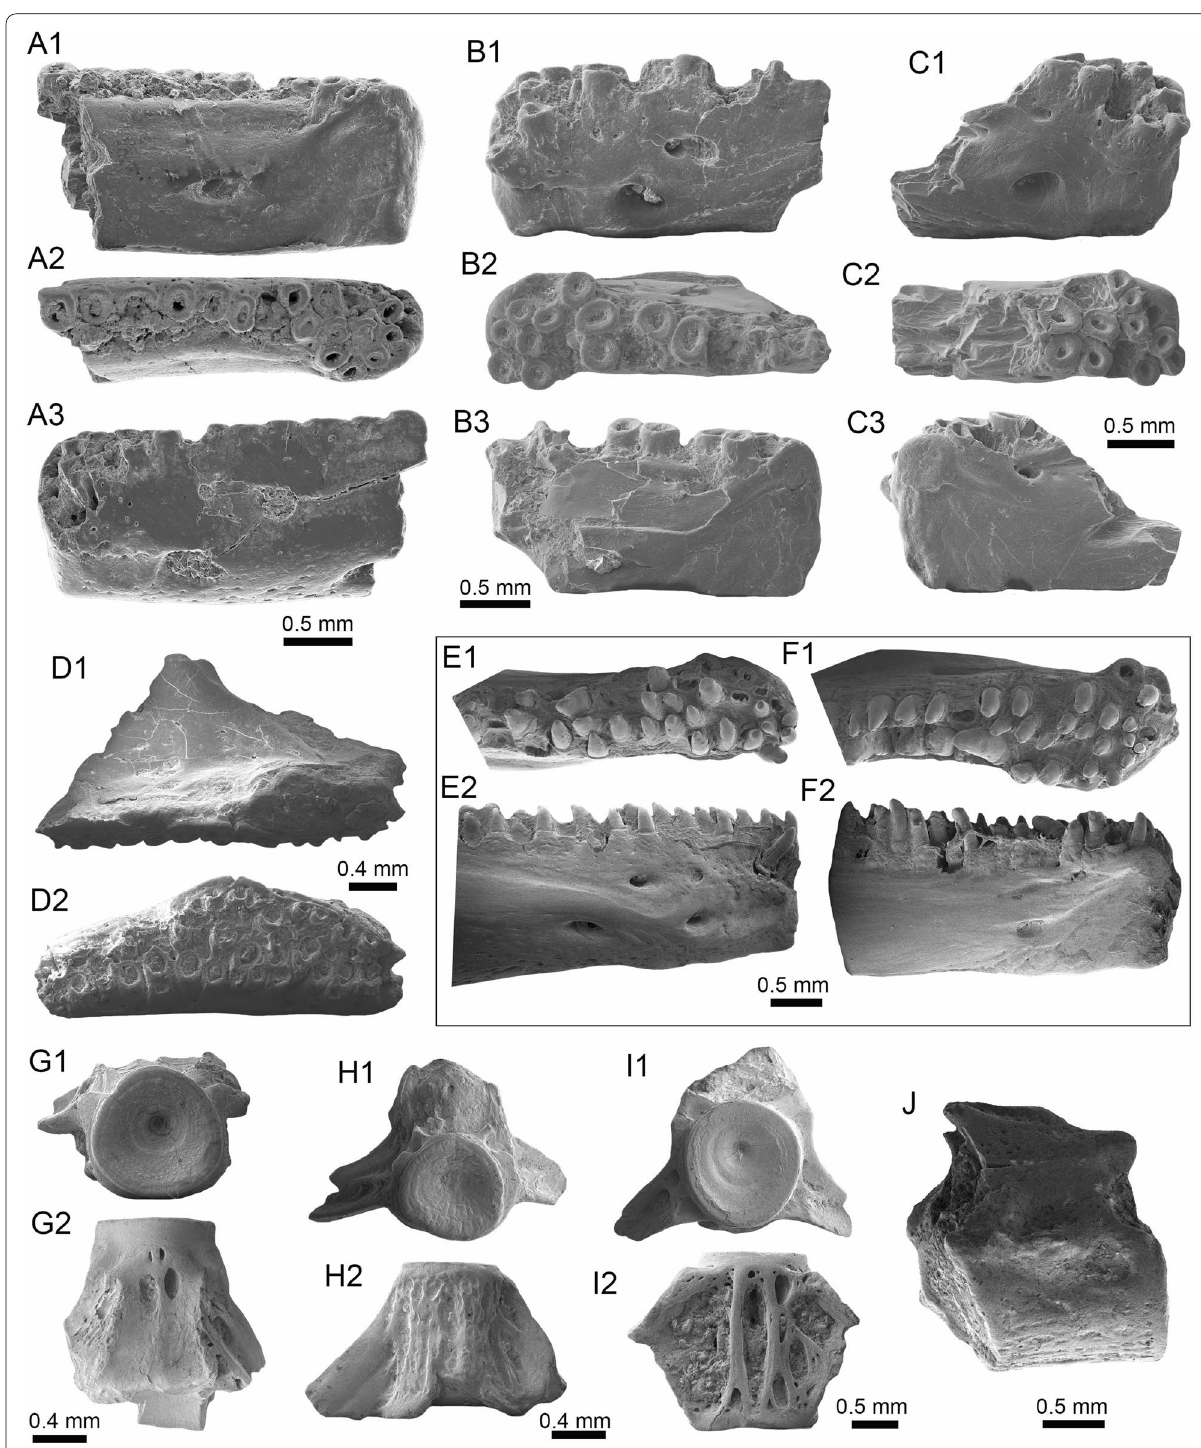
Fig. 12 Synbranchus sp. from the Vergel Member. A1 – C3 Dentaries (right: A1 – A3 , C1 – C3 , and left: B1 – B3 ; AMU‑CURS‑1146‑a‑c) and branchial bones ( D1 , D2 AMU‑CURS‑1146‑d). E1 – F2 Right ( E1 , E2 ) and left ( F1 , F2 ) dentaries of extant Synbranchus marmoratus (PIMUZ A/I 4873). G1 – J Isolated vertebrae of Synbranchus sp. (AMU‑CURS‑1171). Views: anterior ( G1 , H1 , I1 ), left lateral ( B1 ), right lateral ( A1 , C1 , E2 ), lateral ( D1 , J ), medial ( A3 , B3 , C3 , F2 ), occlusal ( A2 , B2 , C2 , E1 , F1 ), and ventral ( D2 , G2 , H2 , I2